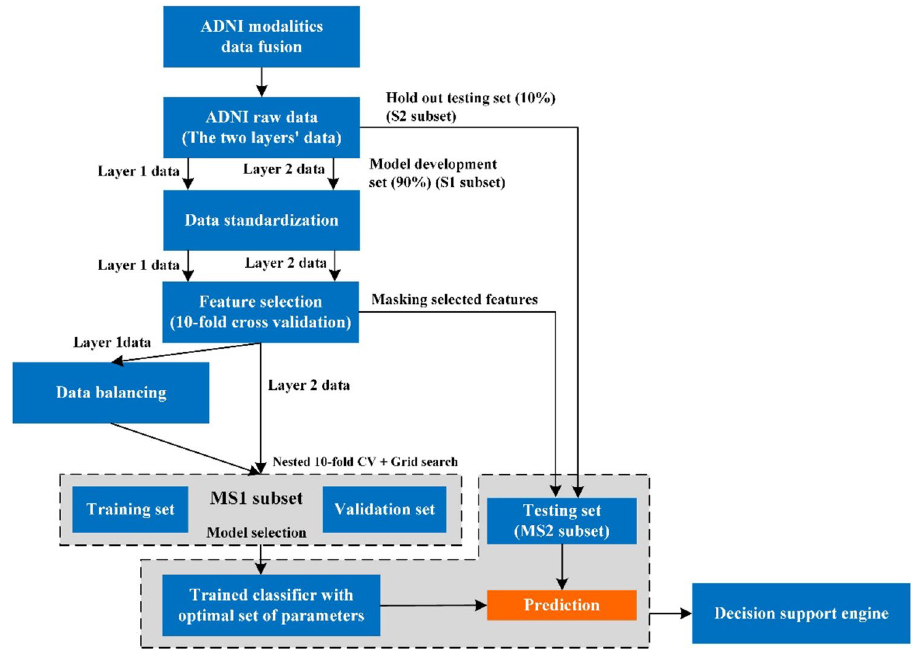
Figure 5. Development process for the oracle model in each